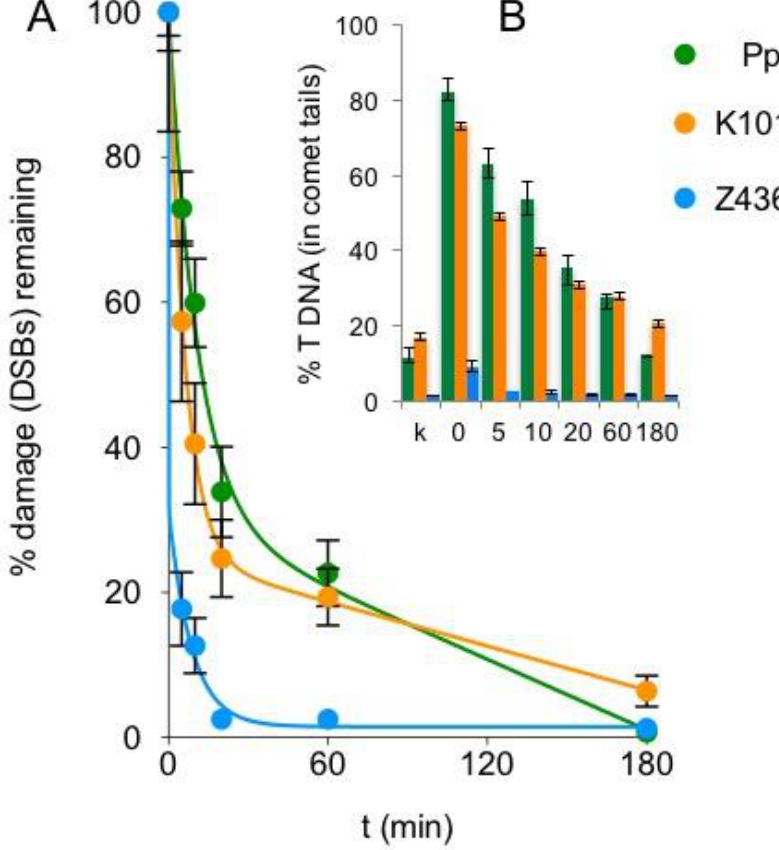
Figure 6. Kinetics of DSBs repair. The cultures of Klebsormidium flaccidum K101 (orange), Zygnema sp Z436 (blue) and Physcomitrella (green) were treated for 1 h with 30 µ g bleomycin/mL and allowed to recover for the indicated times. The fraction of DNA measured in comet tails % T DNA (embedded graph B) was normalized to 100% damage after treatment (t = 0), to highlight differences among each strain. The graph plot A was generated as approximation of two-phase decay kinetics through the experimental points by the Prism v.5 program.